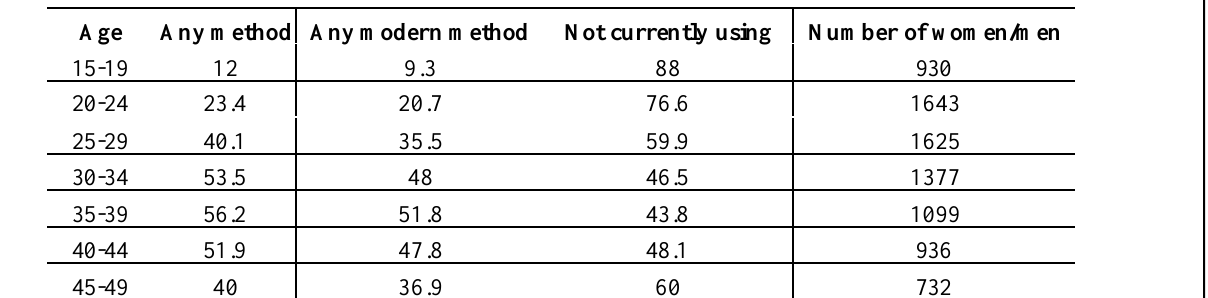
Table V : Percent distribution of currently married women by contraceptive currently used, Nepal 2001